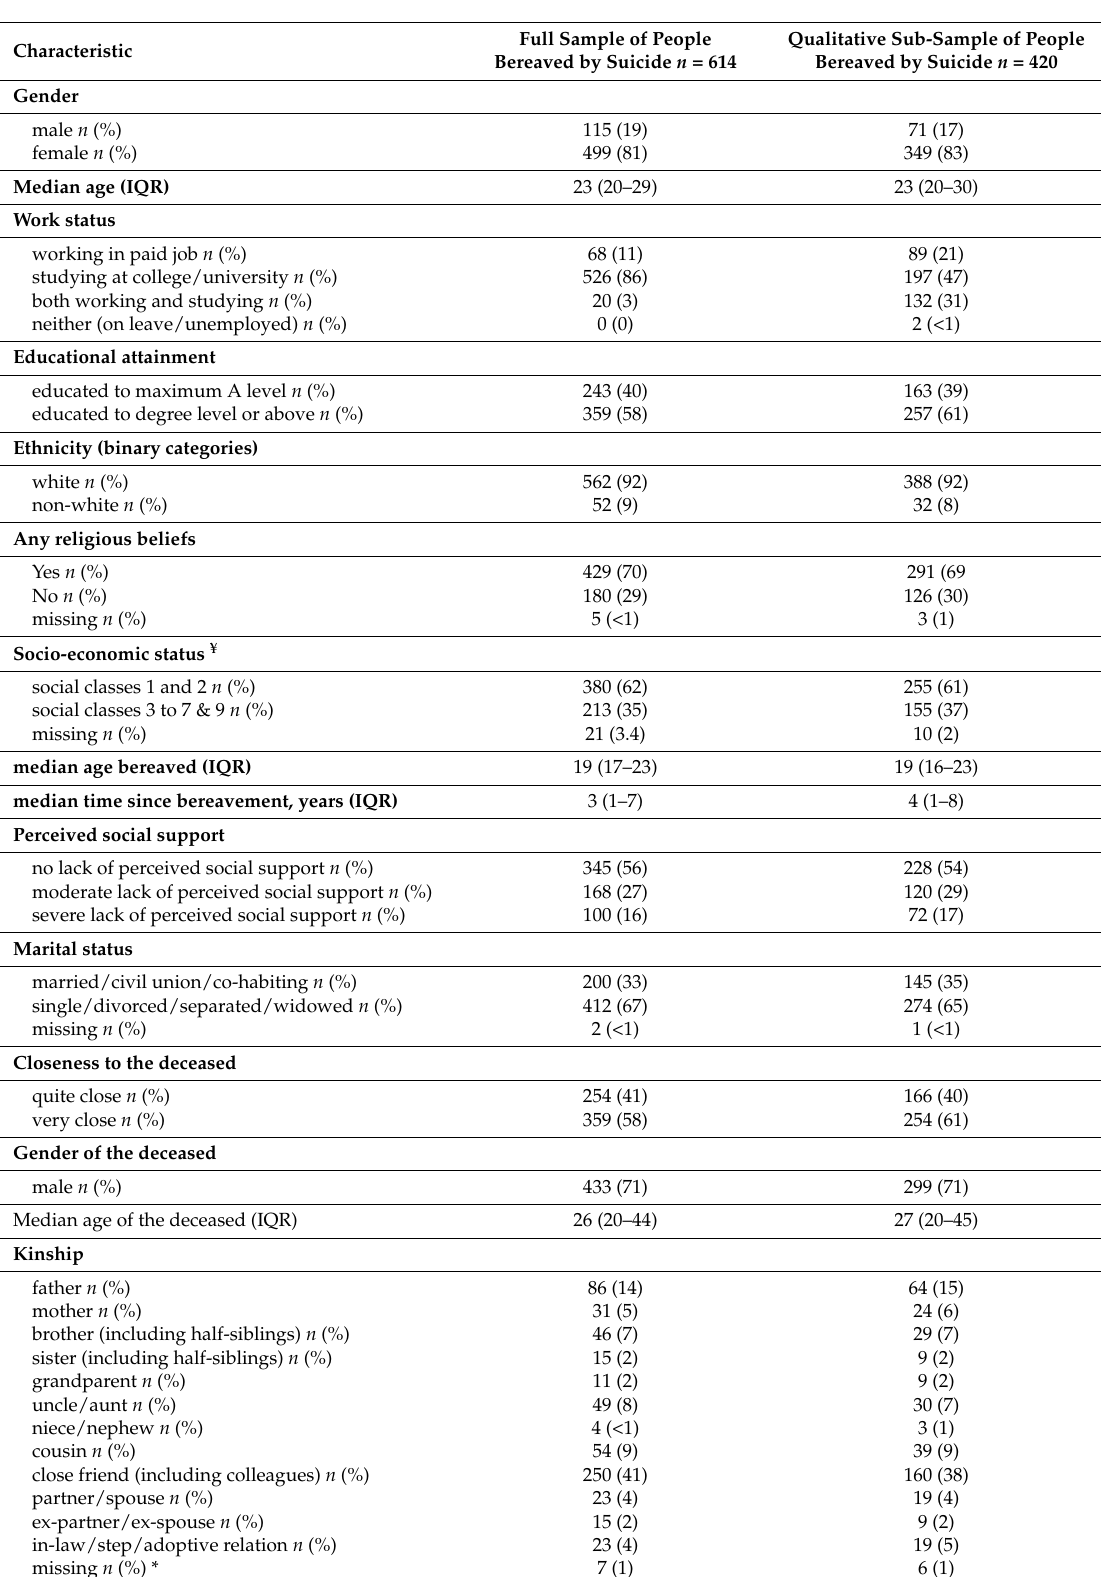
Table 1. Demographic characteristics of the 420 respondents compared with the full sample of 614 people bereaved by